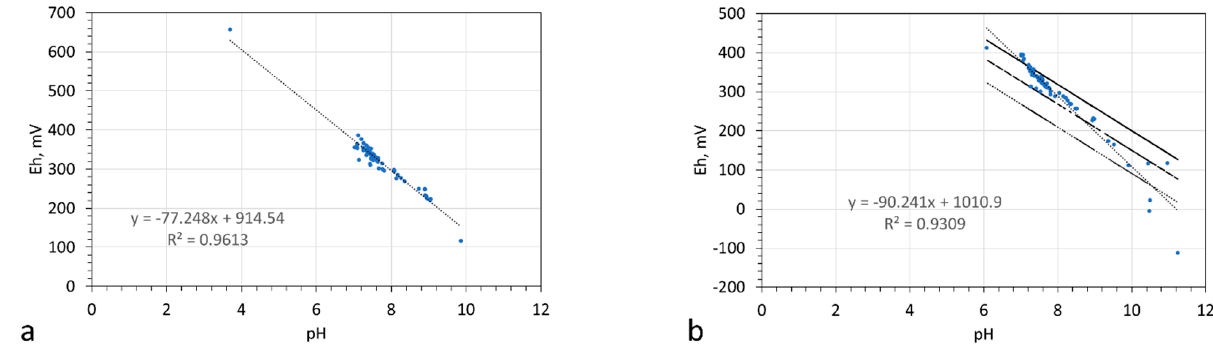
Figure 11. Redox diagram: ( a ) feed water; ( b ) product water. The equilibrium ratios of P [O 2 ]: H 2 O 2 in this redox environment are provided as: solid line = 5000; dashed line = 100; dot-dash line = 1.